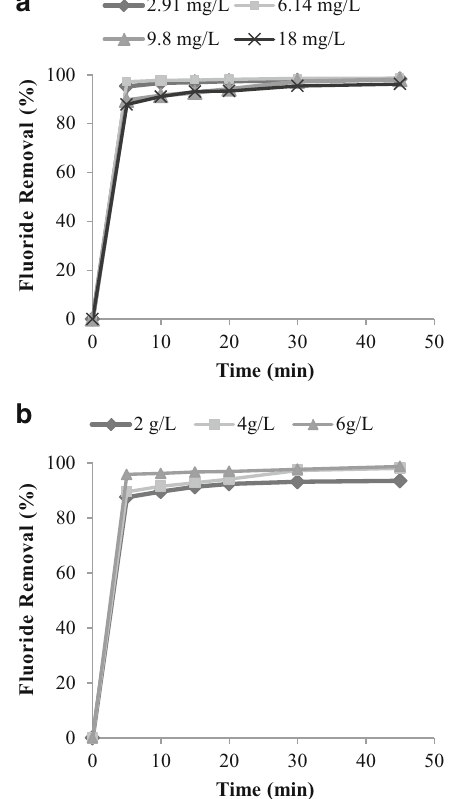
Fig. 6 a Kinetic study at different initial fluoride concentrations (adsorbent dose: 4 g/L, volume of solution: 50 mL, pH: 3 and temperature 25 (cid:3) C). b Kinetic study at different adsorbent doses (initial fluoride concentration: 10.4 mg/L, volume of solution: 50 mL, pH: 3 and temperature 25 (cid:3)